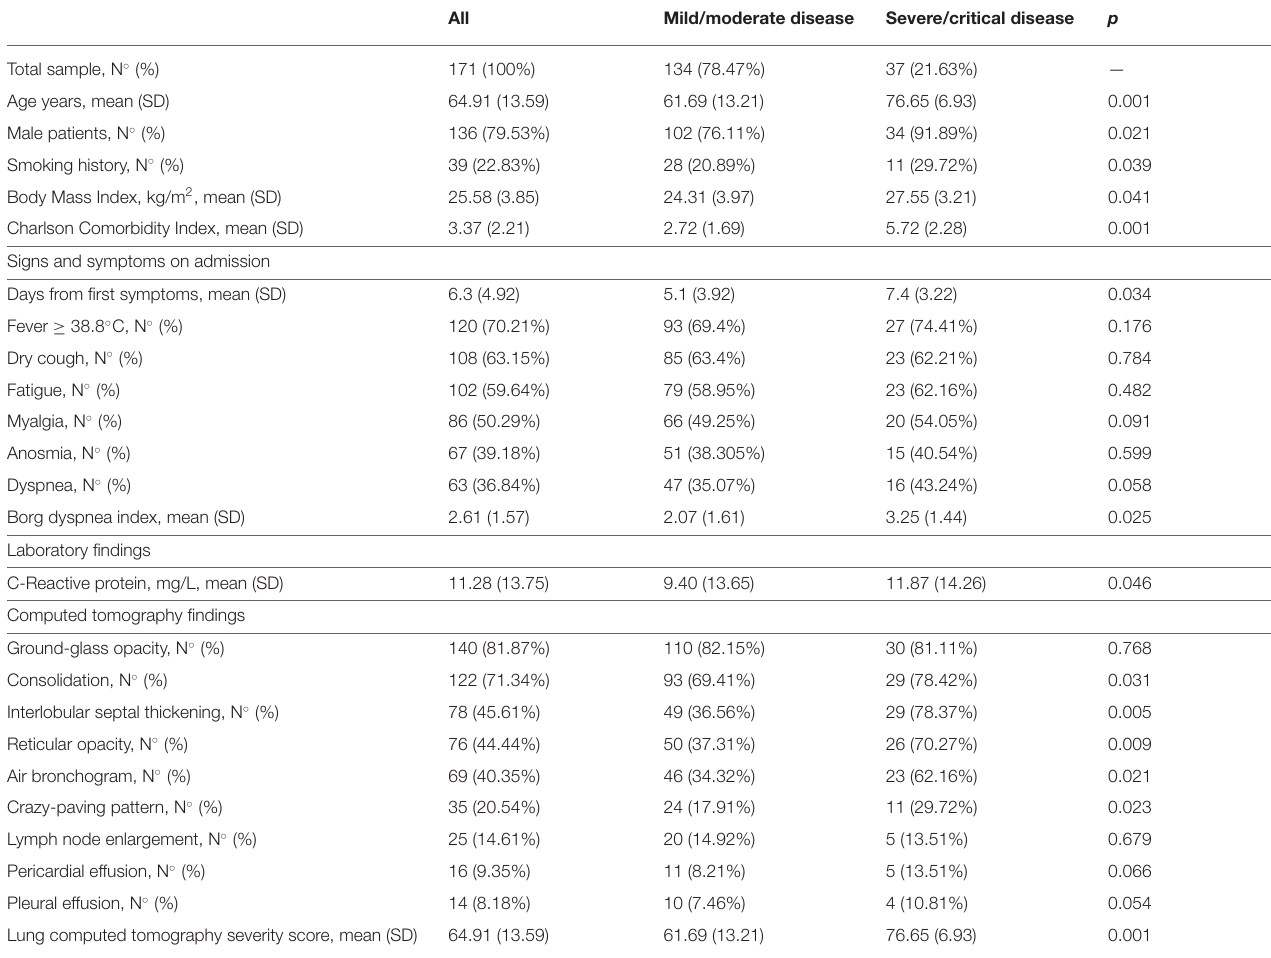
TABLE 1 | Demographic, clinical, laboratory findings of patients on admission. All Mild/moderate disease Severe/critical